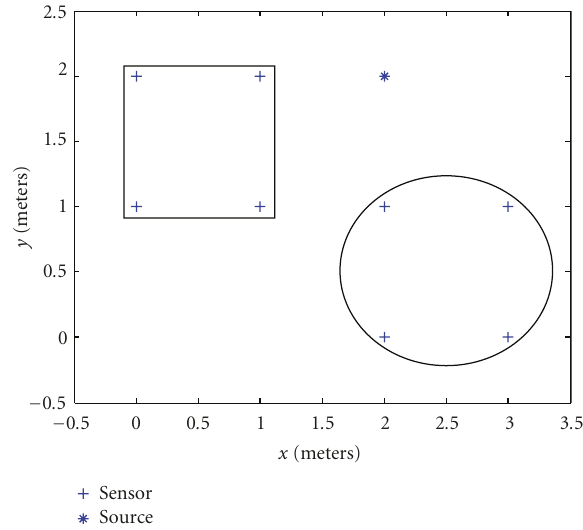
Figure 5: Locations of the eight senors and the source.